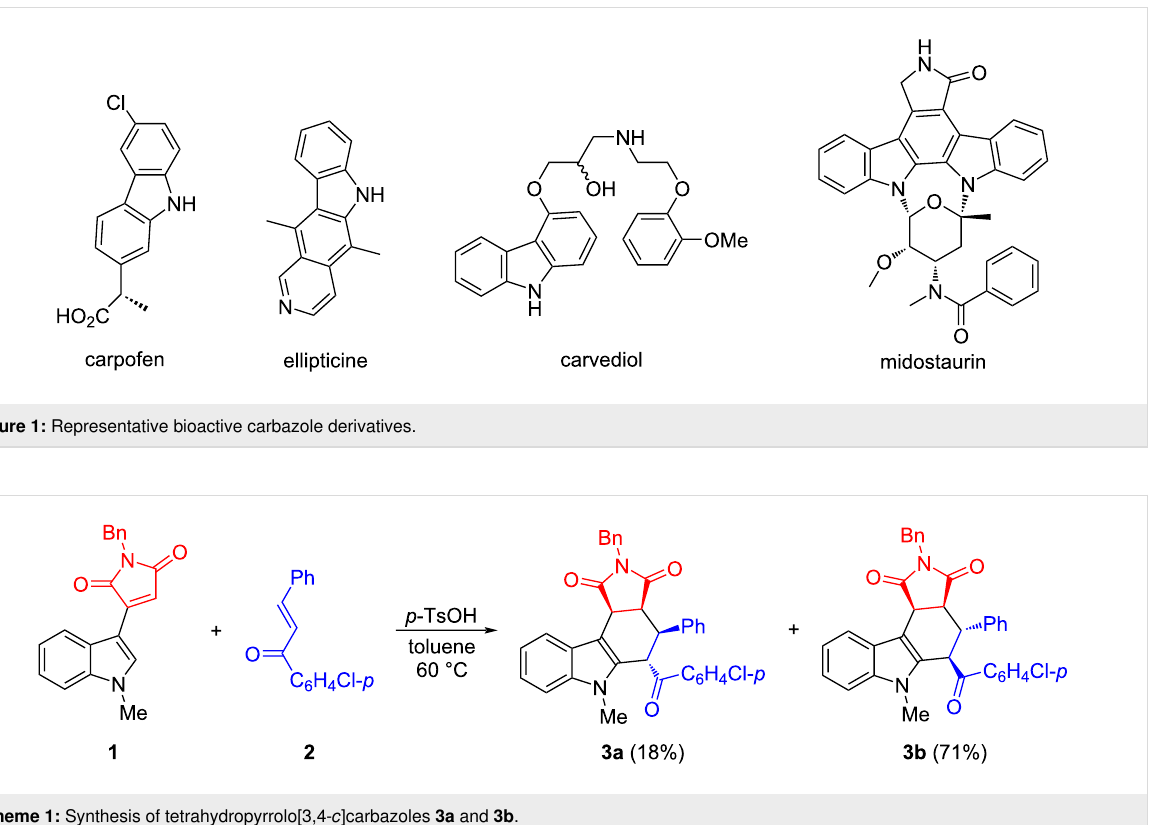
Scheme 1: Synthesis of tetrahydropyrrolo[3,4- c ]carbazoles 3a and 3b